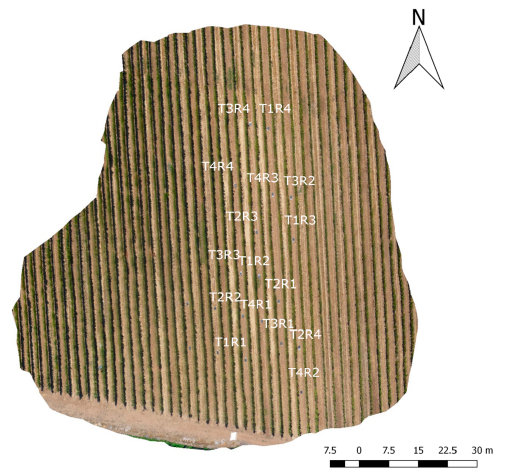
Figure 1. Treatments (T) and Repetitions (R) field distribution.